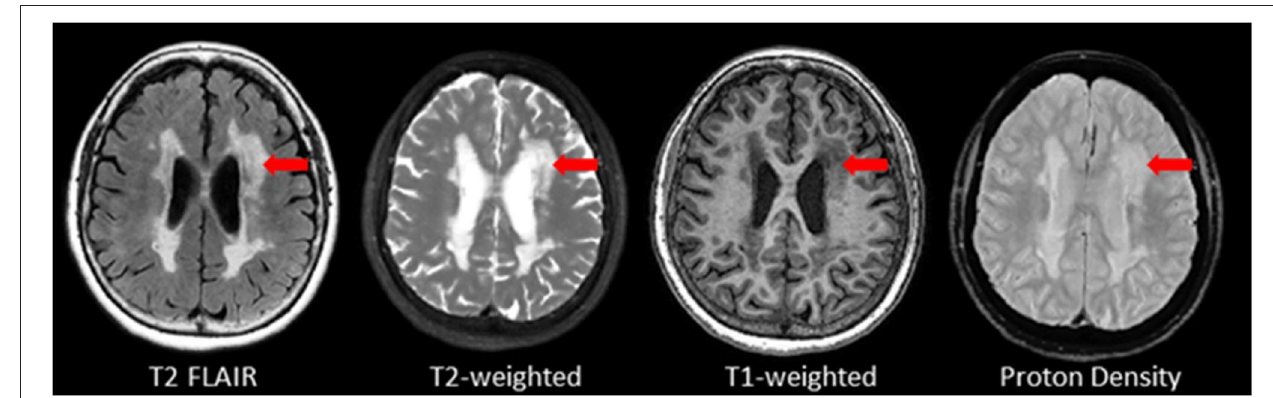
FIGURE 7 | Axial view of various coregistered structural MRI sequences showing the relative intensity differences of WMH. Note that white matter hyperintensities are not hyperintense (i.e., bright) on T1-weighted MRI.